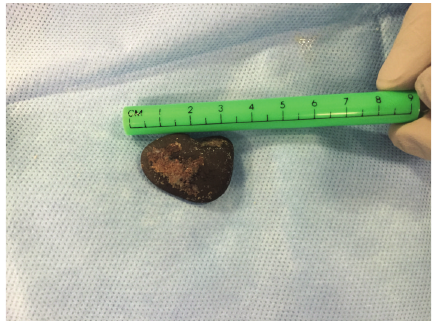
Figure 3: The foreign body after retrieval.